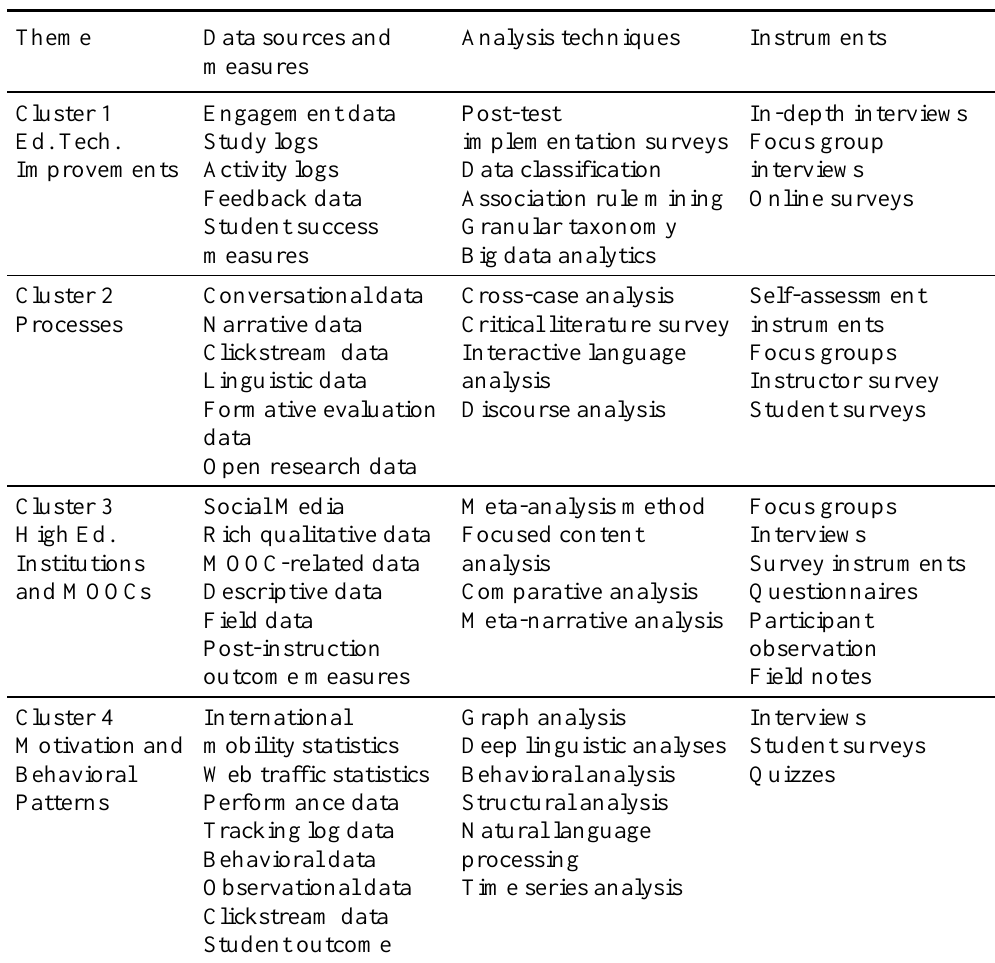
Phase 1 Research Themes Data Analysis